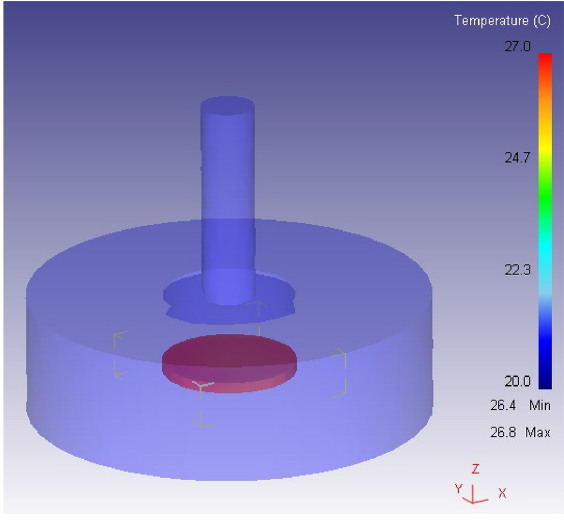
Fig.8: Temperature distribution after HPT